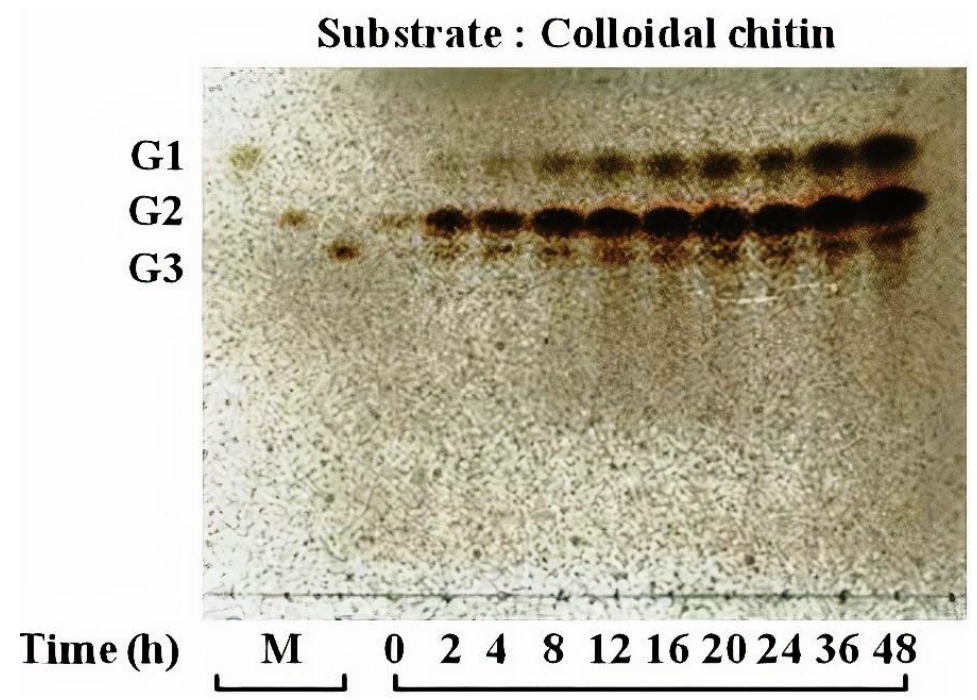
Figure 4. Thin-layer chromatography (TLC) analysis of reaction products of colloidal chitin incubated with chitinase 1198. Reaction mixtures containing 16.45 mg/mL of colloidal chitin as a substrate in 50 mM sodium phosphate buffer (pH = 6.5) were incubated with chitinase 1198 (3.97 M) at 40 °C for the indicated times (0, 2, 4, 8, 12, 16, 20, 24, 36, and 48 h). Lane M, standard GlcNAc or its oligomers ranging from (GlcNAc) 1 to (GlcNAc) 3 designated as G1 to G3.